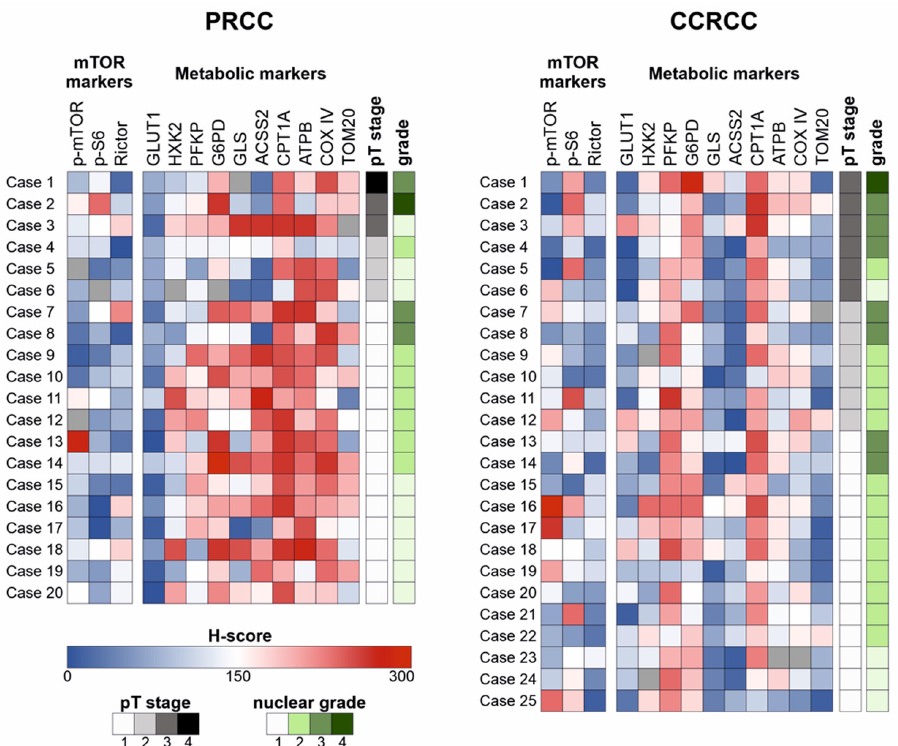
Figure 2. Heat map visualization of the scored in situ expression analyses of mTOR and metabolic pathway markers in papillary (PRCC) and clear cell renal cell carcinomas (CCRCC). Immunohisto- chemical expression of the markers was visualized on a heat map in each case. Blue color indicates low expression, whereas red color indicates high expression. Missing values are shown in grey. The pT stage and nuclear grade are also available.